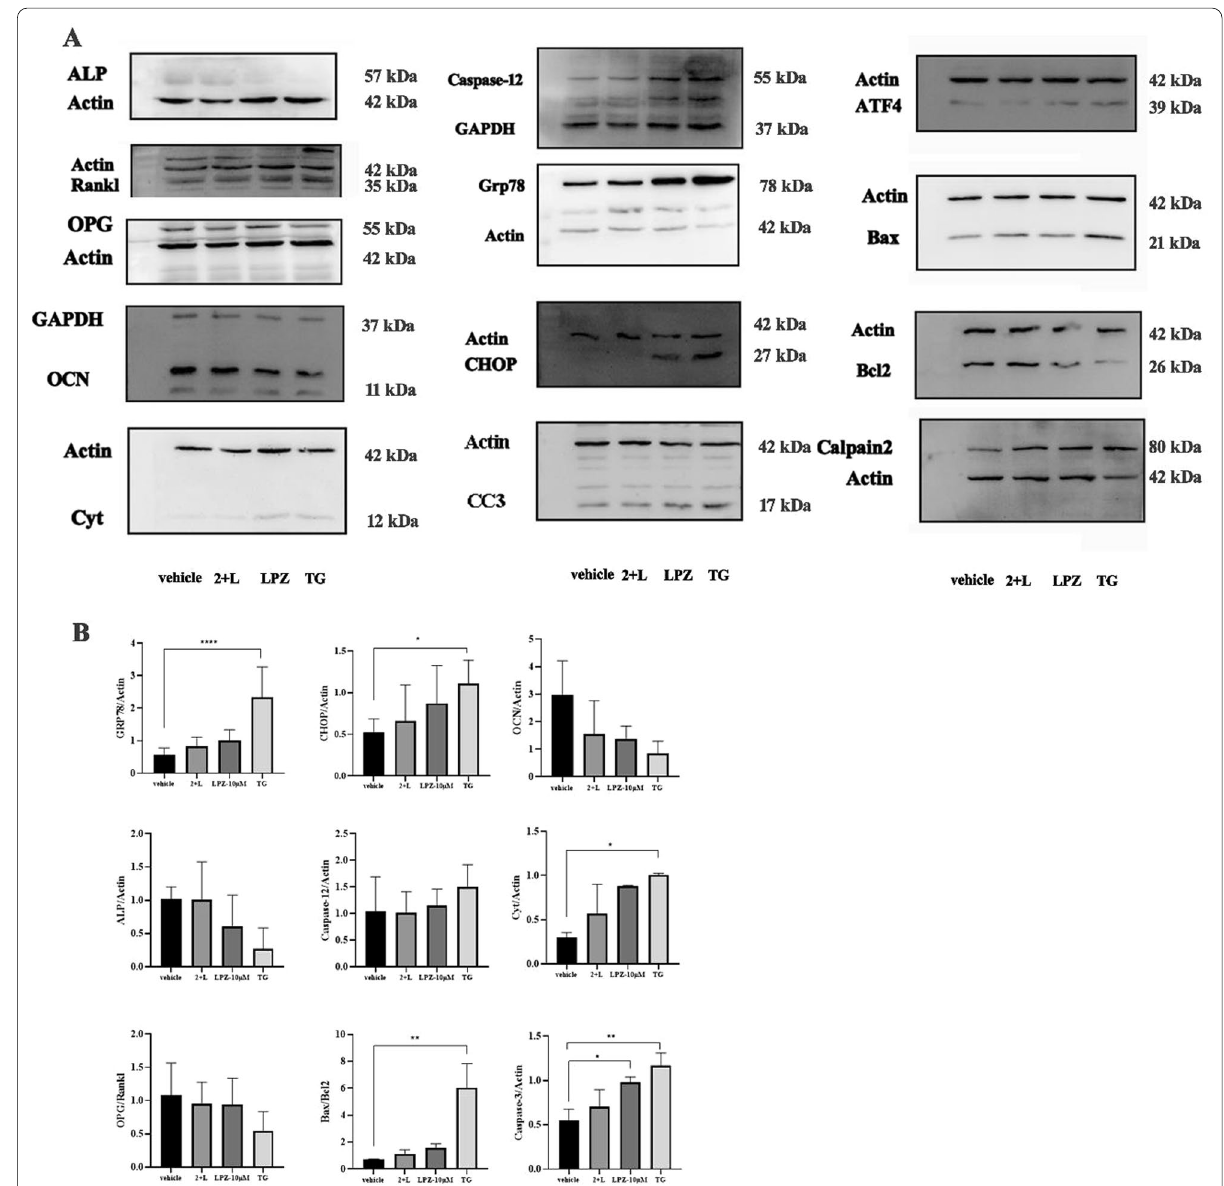
Fig. 11 The expression of OB functional genes and ER stress- and apoptosis pathway-related proteins. A Western blot analysis after LPZ, 2-APB, and TG treatment. B Semiquantitative analysis of protein levels in MC3T3-E1